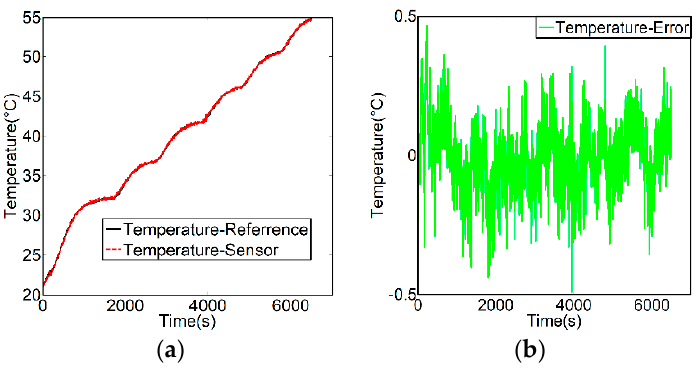
Figure 5. ( a ) Comparison of the measurement results of the airflow-temperature sensor with the reference temperature. ( b ) Measurement error of airflow-temperature sensor.